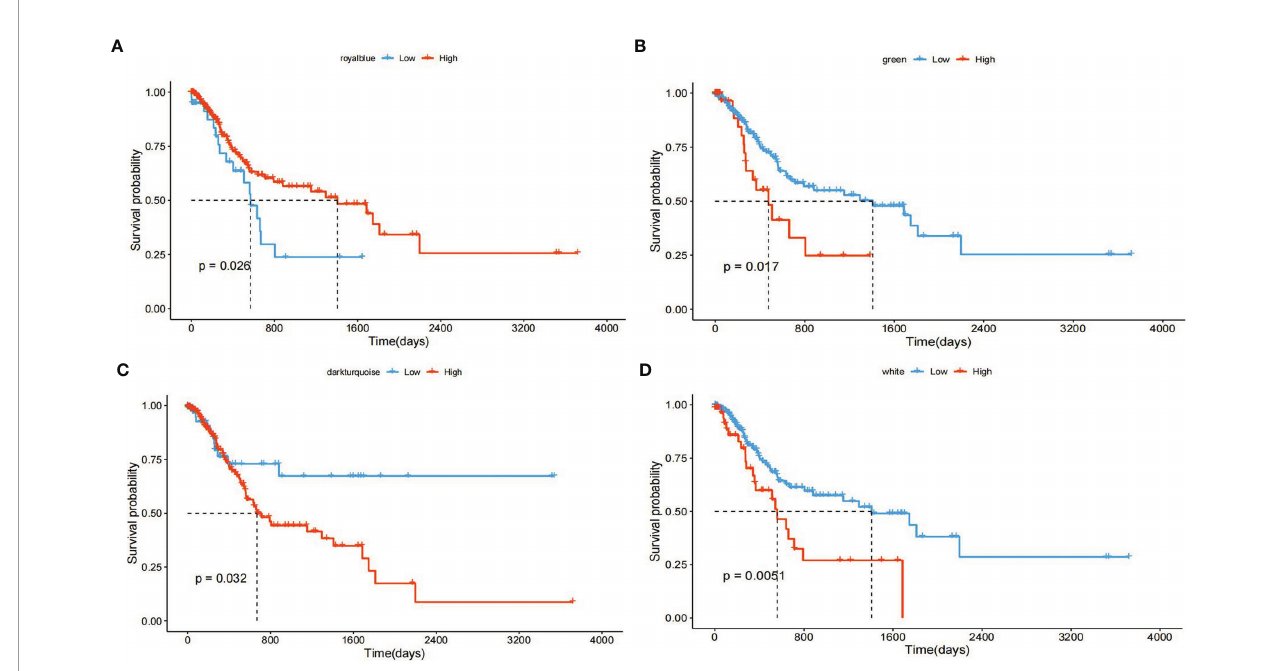
FIGURE 1 | Kaplan – Meier plot with the univariate survival analysis of four gene modules. (A) The Kaplan – Meier plot shows that patients with a higher “ MEdarkturquoise ” value have shorter OS (blue lines), and patients with a lower “ MEdarkturquoise ” value have longer OS (red lines). (B) The Kaplan – Meier plot shows that patients with a higher “ MEgreen ” value have shorter OS (blue lines), and patients with a lower “ MEgreen ” value have longer OS (red lines). (C) The Kaplan – Meier plot shows that patients with a higher “ MEroyalblue ” value have shorter OS (blue lines), and patients with a lower “ MEroyalblue ” value have longer OS (red lines). (D) The Kaplan – Meier plot shows that patients with a higher “ MEwhite ” value have longer OS (blue lines), and patients with a lower “ MEwhite ” value have shorter OS (red lines).